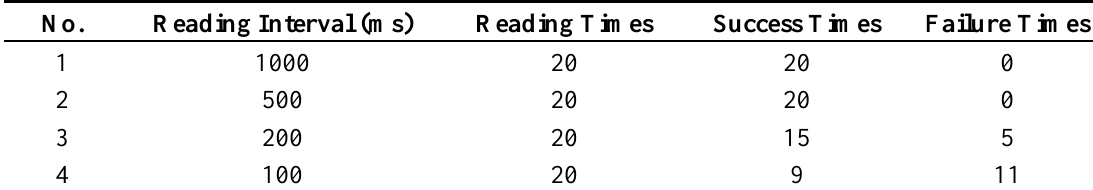
Table 6. Zigbee reading experiment